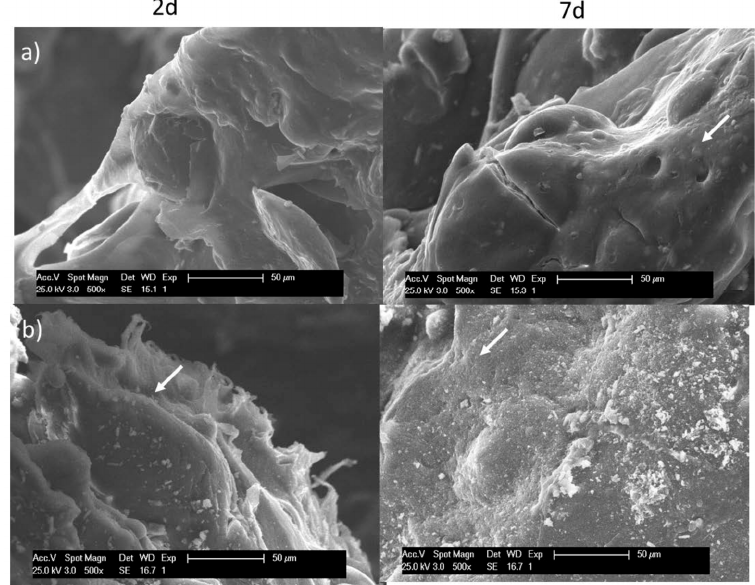
Figure 8. SEM images of hBMSCs colonization on blank and Sr(II) scaffolds at different times post-seeding. ( a ) Ch/PCL and ( b ) Sr/Ch/PCL. Ch: chitosan; PCL: poly( ε -caprolactone).